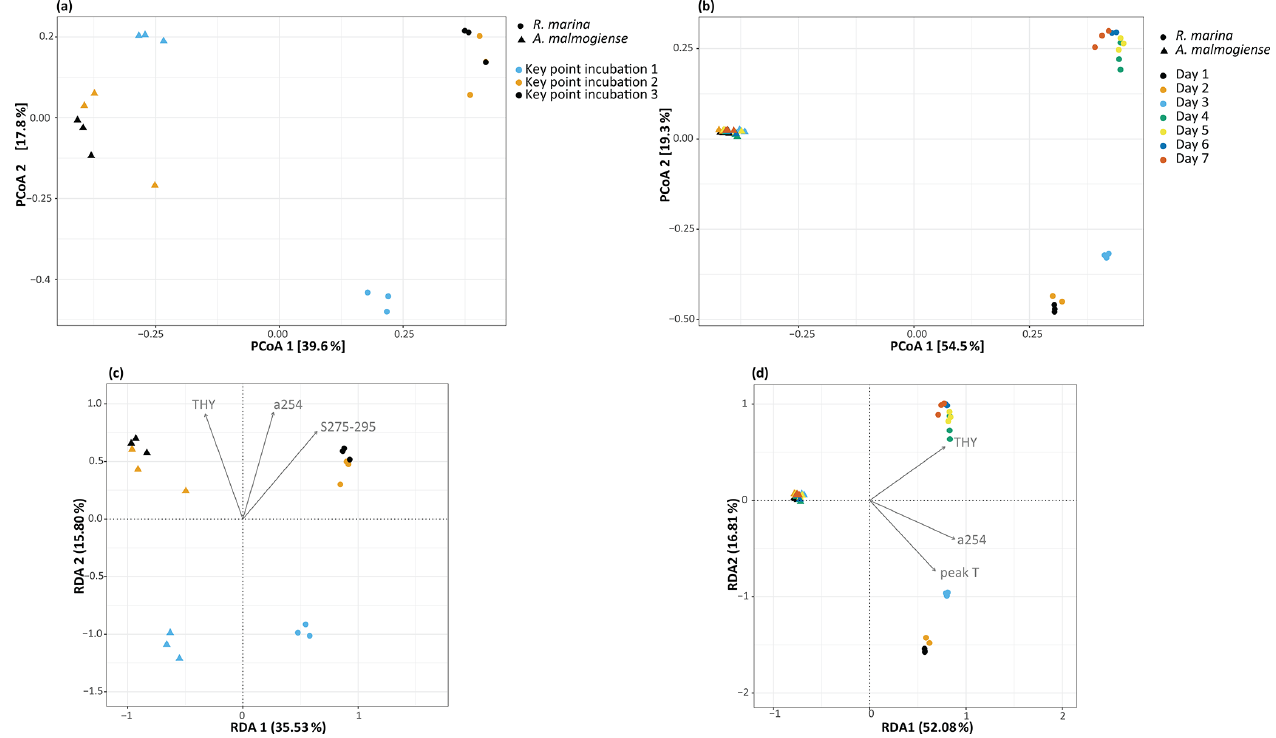
Figure 7. (a, b) Principal coordinate analysis plots showing bacterial community dynamics in different experiments and (c, d) dbRDA biplots showing the relationship between bacterial communities and selected significant environmental variables (ANOVA, p< 0 . 05) in the DOM release experiment (a, c) and DOM consumption experiment (b, d) . THY: thymidine based bacterial production; a254: a CDOM ( 254 ) ; S 275 − 295 : S 275 − 295